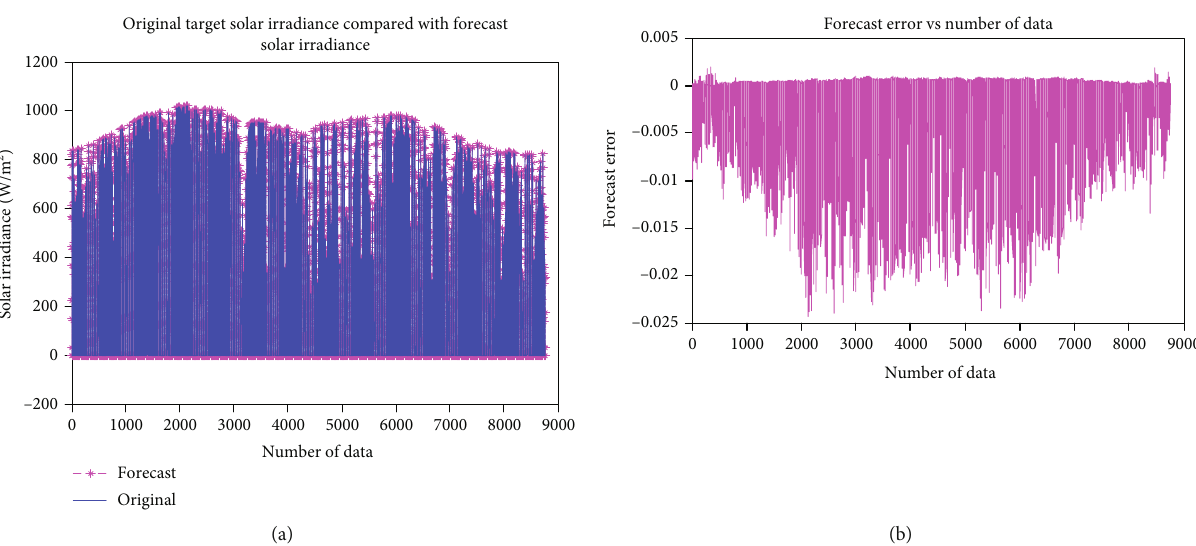
Figure 17: (a) Six input MLPNN-based forecasting model original targets compared to forecast solar irradiance. (b) Six input MLPNN- based forecasting model forecasting errors vs. the number of data